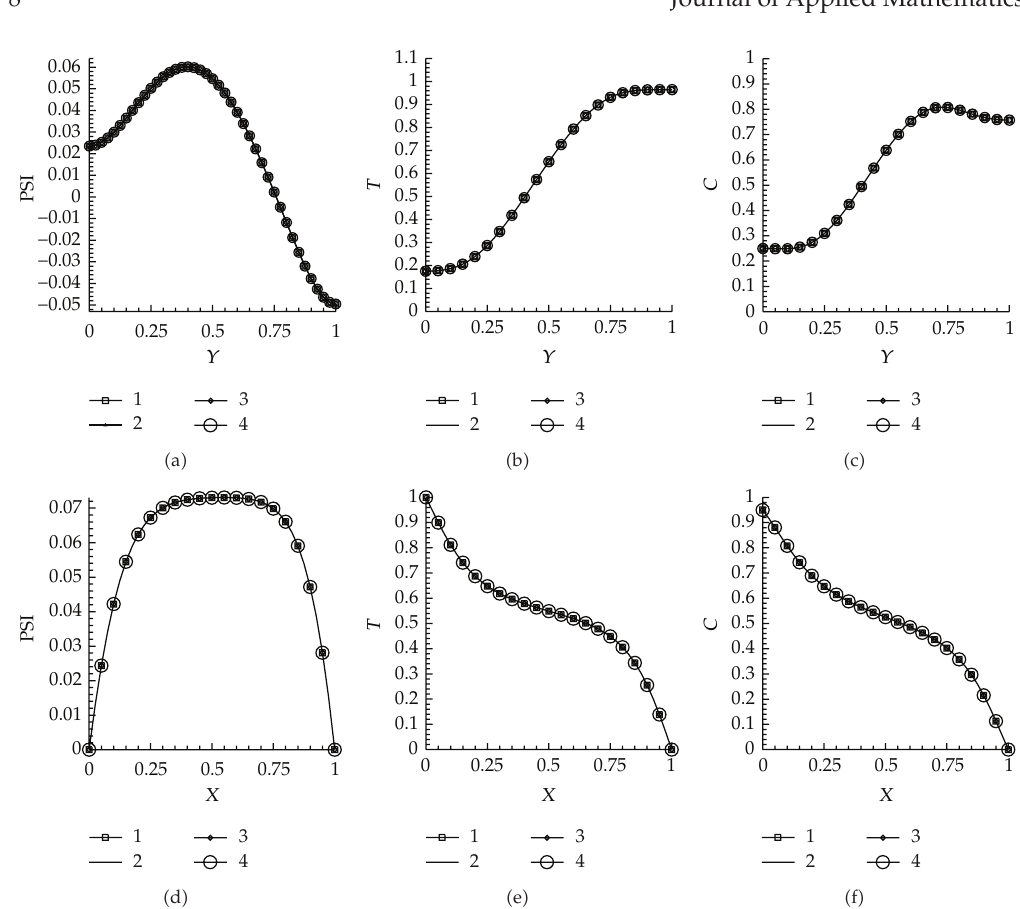
Figure 3: Grid selection results on di ff erent grid systems (cid:2)(cid:2) 1 (cid:3) 21 × 21, (cid:2) 2 (cid:3) 31 × 31, (cid:2) 3 (cid:3) 41 × 41, (cid:2) 4 (cid:3) 51 × 51 (cid:3) for (cid:2) a (cid:3) stream function, (cid:2) b (cid:3) temperature, and (cid:2) c (cid:3) concentration values when a (cid:8) 0 . 5, Ra (cid:8) 100, (cid:2) D/H (cid:3) (cid:8) S 0.1, Le (cid:8) 1, B (cid:8) 1 along X -axis at fixed Y (cid:8) 0 . 5, and the corresponding plots along Y -axis at fixed X (cid:8) 0 . 5 are in (cid:2) d–f (cid:3) ,